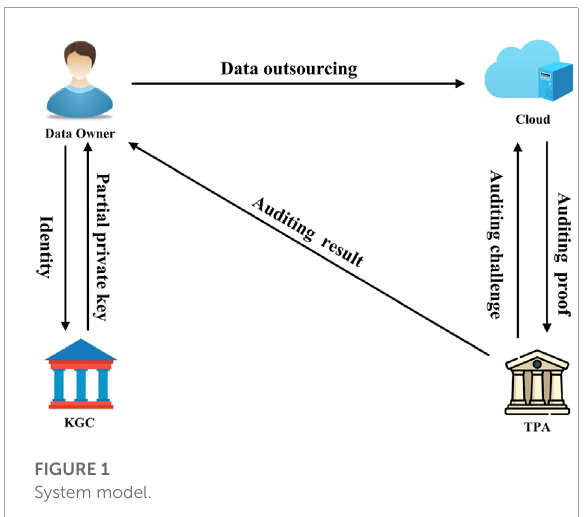
FIGURE 1 System